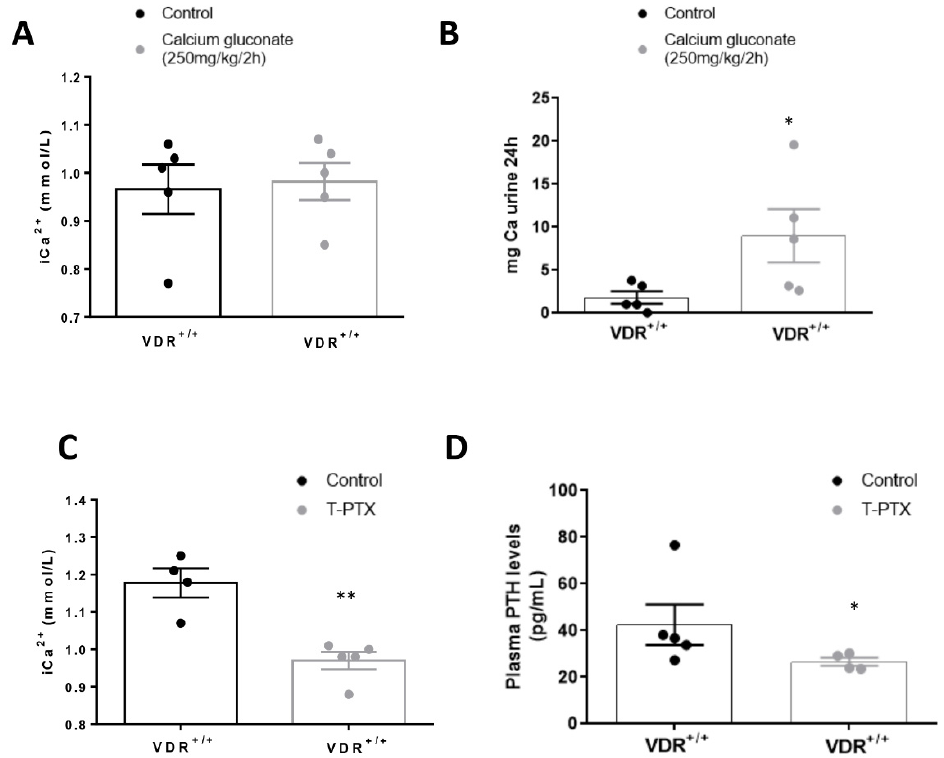
Figure 4. Establishment of a hypercalcemic model in VDR +/+ mice. To evaluate the role of Ca 2+ in FGF23 synthesis, we established a mouse model with thyro-parathyroidectomy (T-PTX). VDR +/+ mice underwent a thyro-parathyroidectomy (T-PTX) induced by electro-cauterization under a dissecting microscope. After the surgery, mice received a daily subcutaneous replacement T4 treatment (L-thyroxine, 40 ng/g). Calcium levels were assessed in plasma samples ( A ) and 24 h urine samples ( B ). Blood samples 4 days after the surgery were taken to assess plasma Ca 2+ (mmol/L) ( C ) and PTH levels (pg/mol) ( D ). Data are expressed as the mean ± SEM of 5–8 animals per group, * p < 0.05 vs. control values; ** p < 0.01 vs. control values.